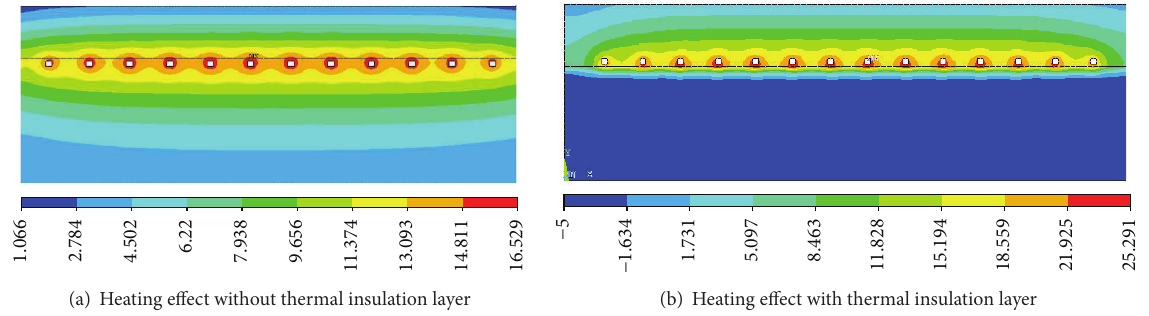
Figure 16: Temperature field distributions with heating time of 5 hours and air temperature of − 5 ∘ C.